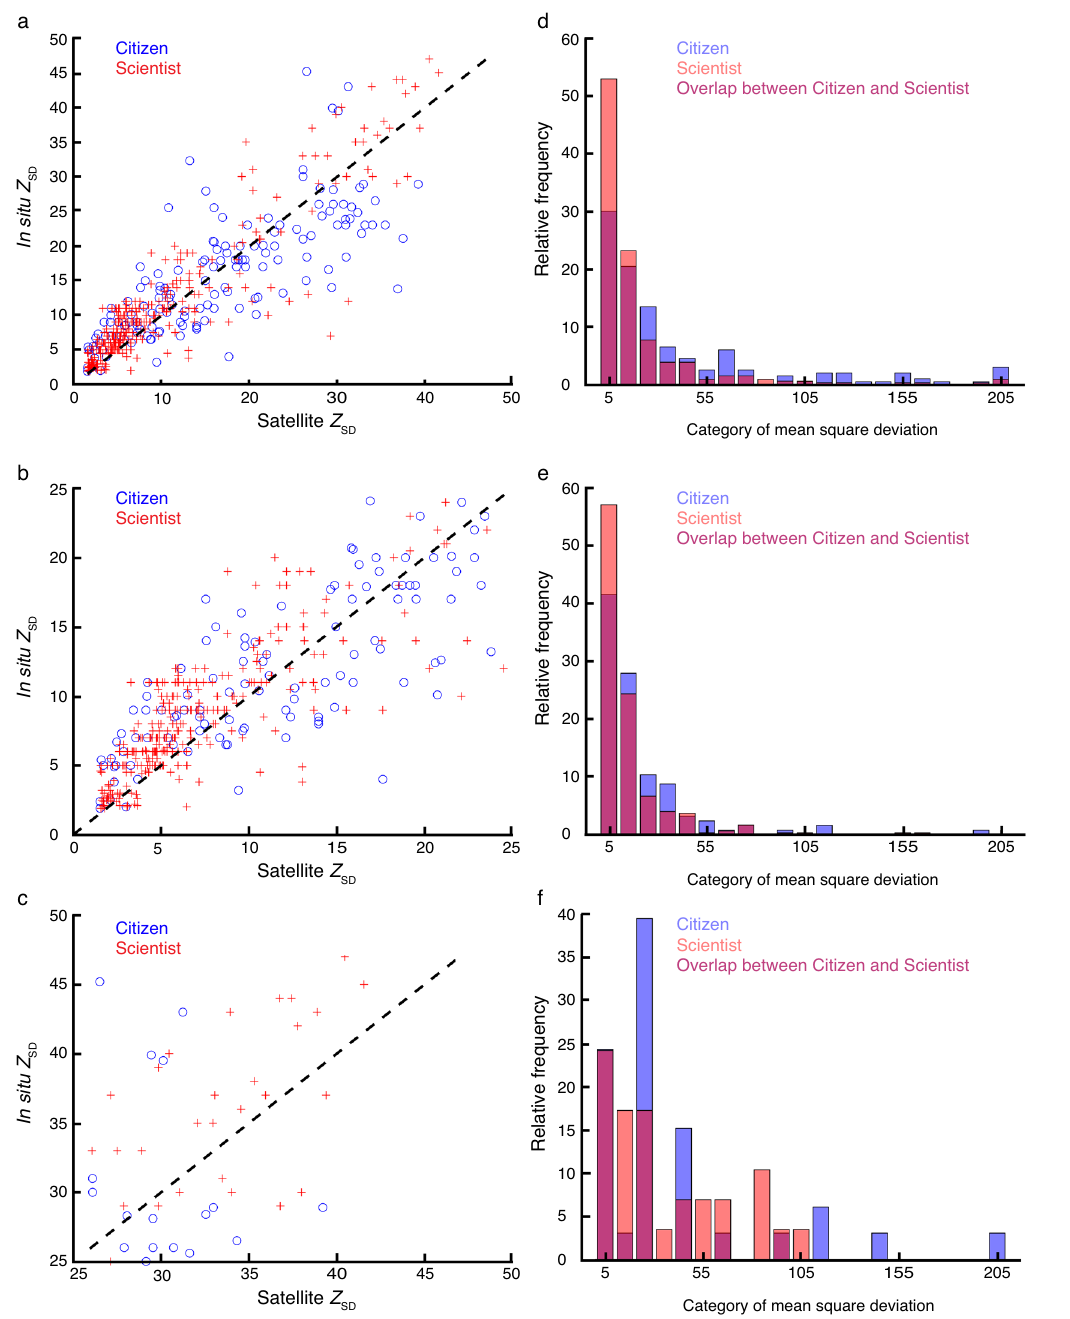
Figure 4. Relationships between citizen and scientist in situ Z SD , and satellite Z SD . ( a–c ) Scatterplots showing the relationship between scientist (red crosses), citizen (blue circles), and satellite Z SD for all the whole dataset, where Z SD < 25 m and where Z SD ≥ 25 m, respectively. Black dashes represent the line y = x. ( d–f ) Histograms of the mean square deviation (m 2 ) for the whole dataset, where Z SD < 25 m and where Z SD ≥ 25 m, respectively. Orange, blue and magenta bars represent scientist, citizen and where scientist and citizen data overlap,